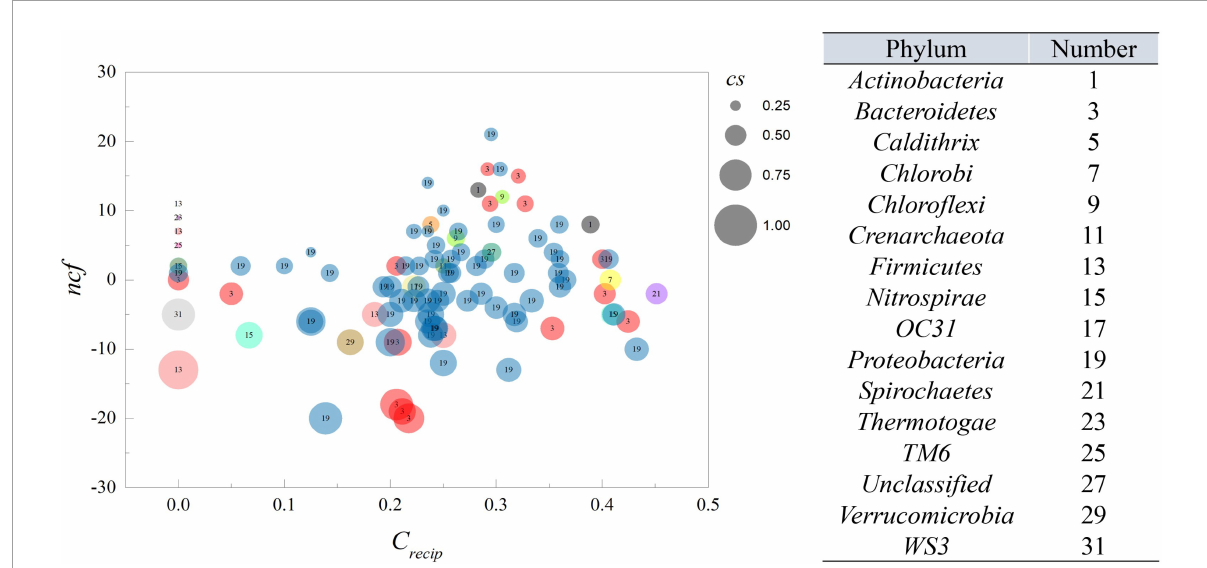
FIGURE2 The ncf and c recip from MGCN. Each circle represents an individual node from MGCN with size representing the cs value. The number within the circle corresponds to the classification of OTU at the phylum level.